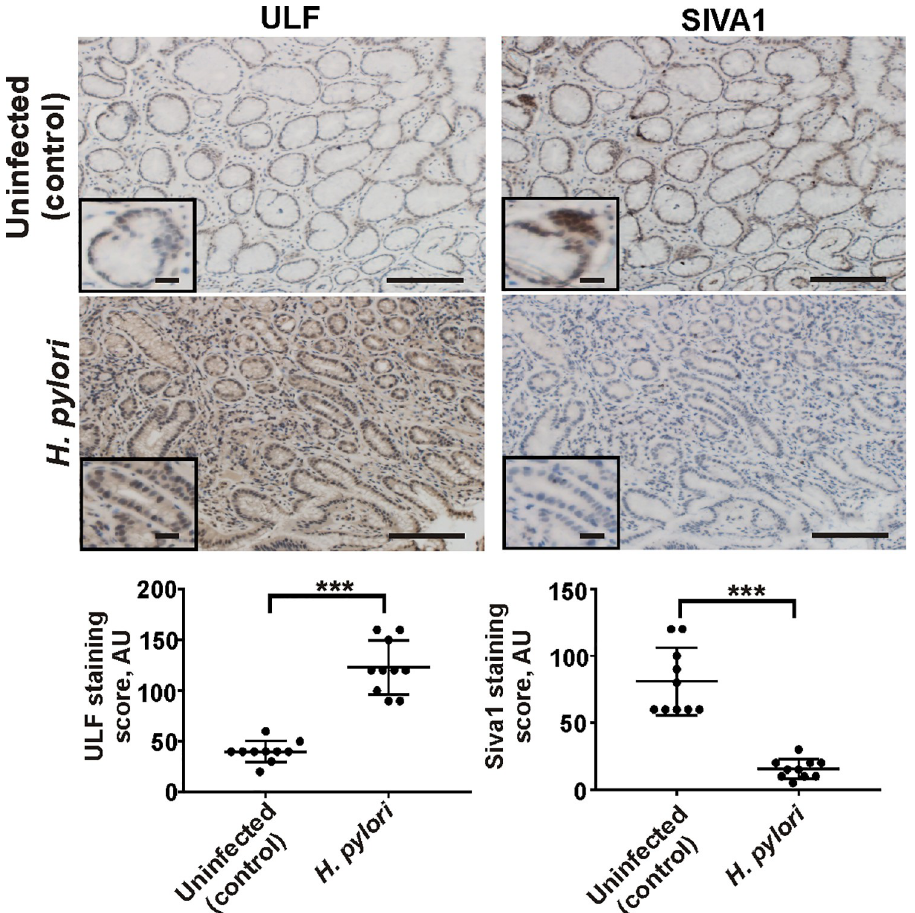
Fig 6. Infection with H . pylori alters expression of ULF and SIVA1 proteins in the human stomach. Representative images showing IHC staining for ULF and SIVA1 proteins in antral gastric biopsies collected from H . pylori -infected and non-infected patients with active chronic gastritis. The graph panels show the IHC scores (n = 10/group). Data were analyzed using unpaired 2-tailed T-test. Insets show the magnified views ( × 40). Scale bars: 50 μ m.